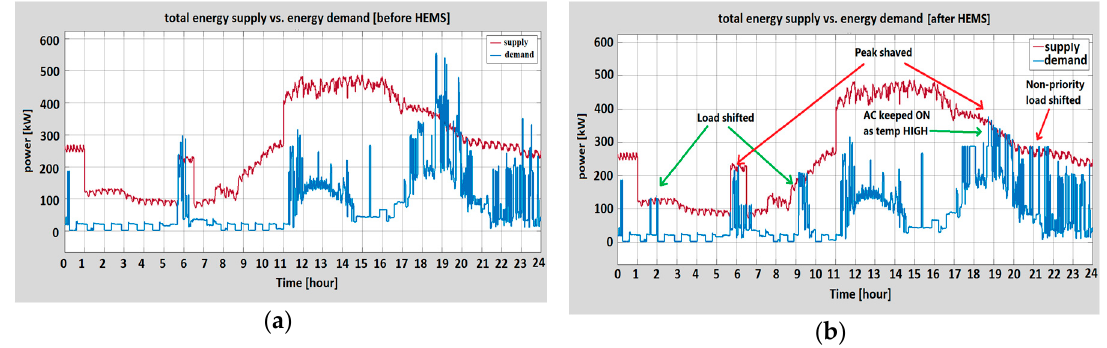
Figure 23. ( a ) Total energy supply and energy demand in Scenario D (all sources available) before HEMS, and ( b ) after HEMS.